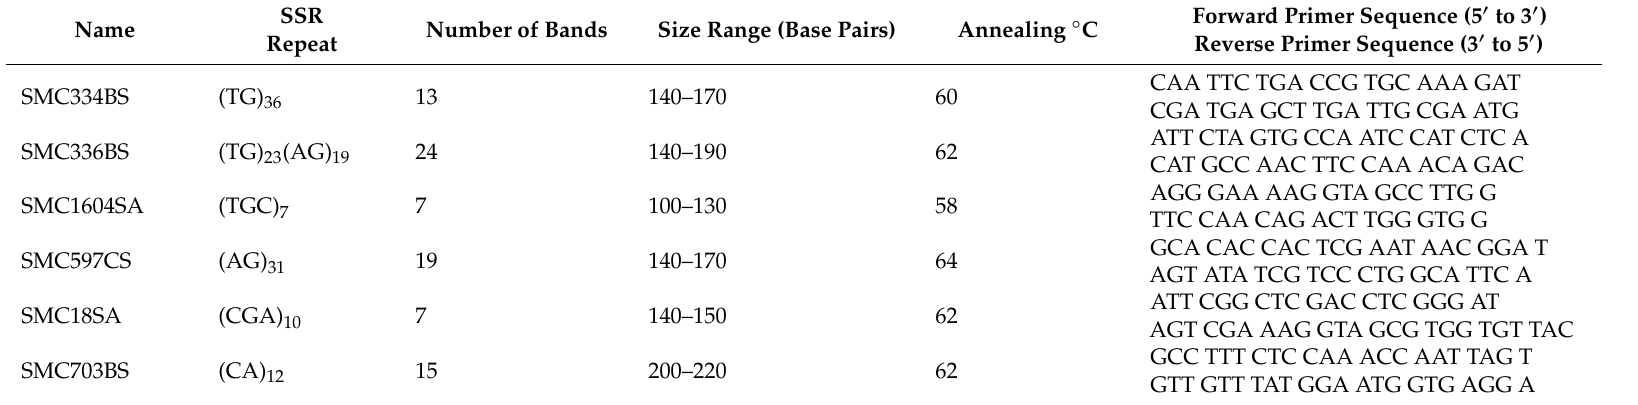
Table 1. Simple sequence repeat (SSR) primer pairs used to identify sugarcane seedlings